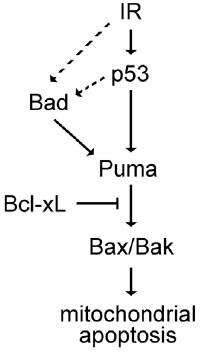
Figure S1 The ability of Bad to radiosensitize zebrafish embry- onic neural tissue is conserved between zebrafish and human. Shown are lateral views of representative tails from 27-hpf wild-type